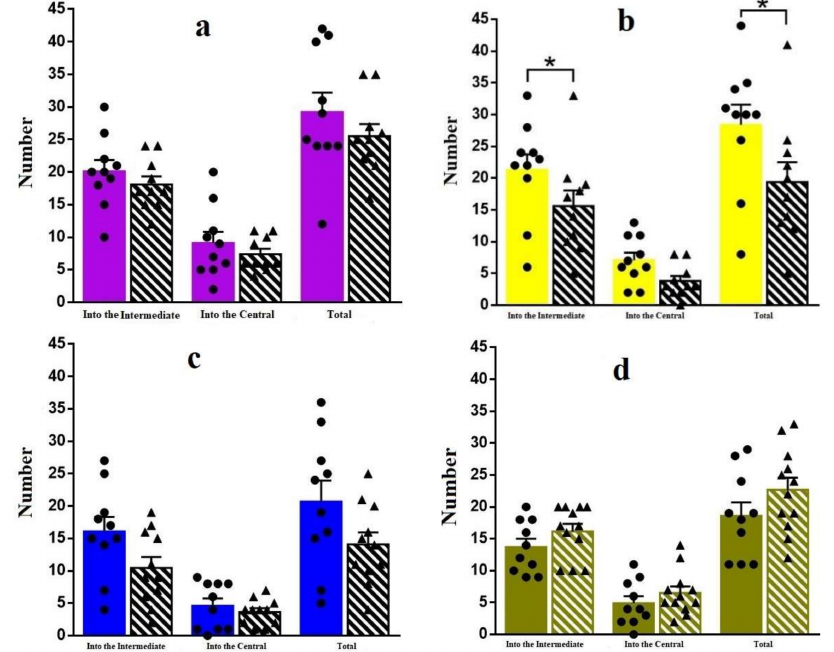
Figure 7. Number of transitions between the areas for different periods of Ag-NP administration: 30 days ( a ); 60 days ( b ); 120 days ( c ); 180 days ( d